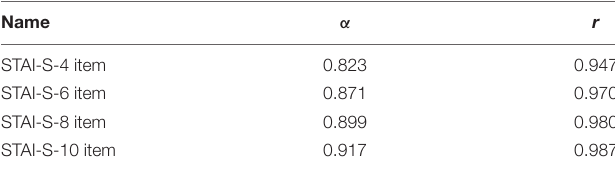
TABLE 3 | Cronbach’s α coefficients and correlation coefficients between the four short versions of the STAI-S scales and the full-length scale ( n =